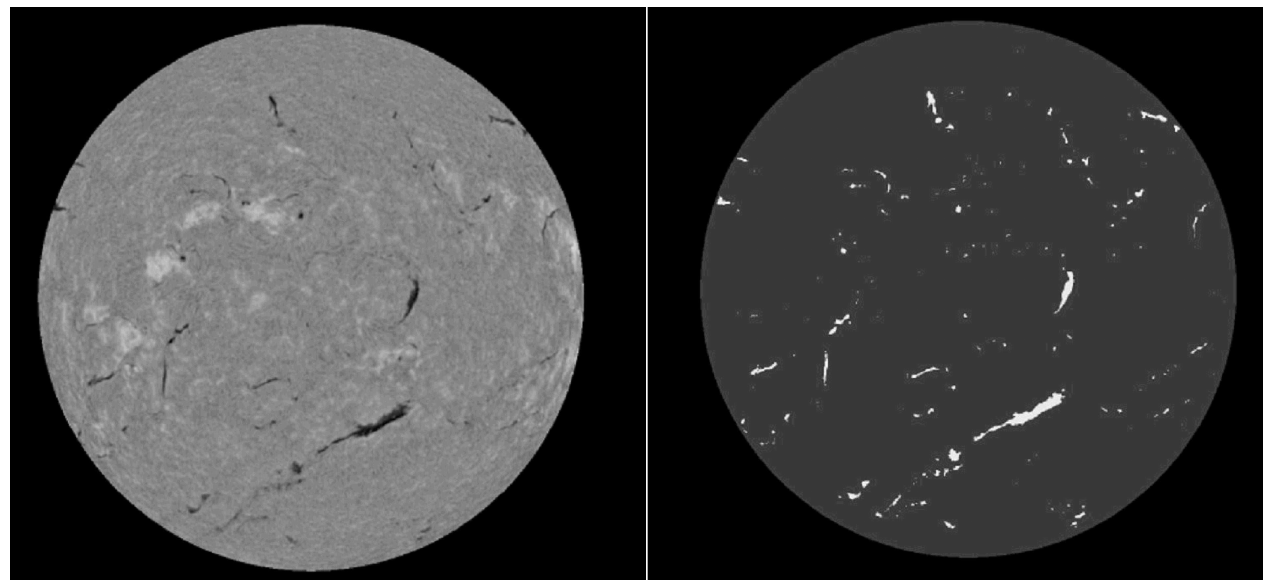
Fig. 1. Example of automatic filament detection. Left image is the original Meudon H α spectroheliogram. Right image shows detected